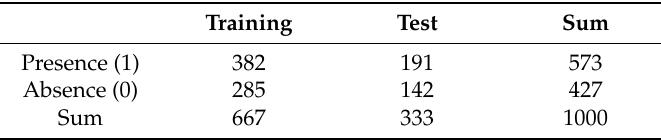
Table 3. Number of sample objects in training and test